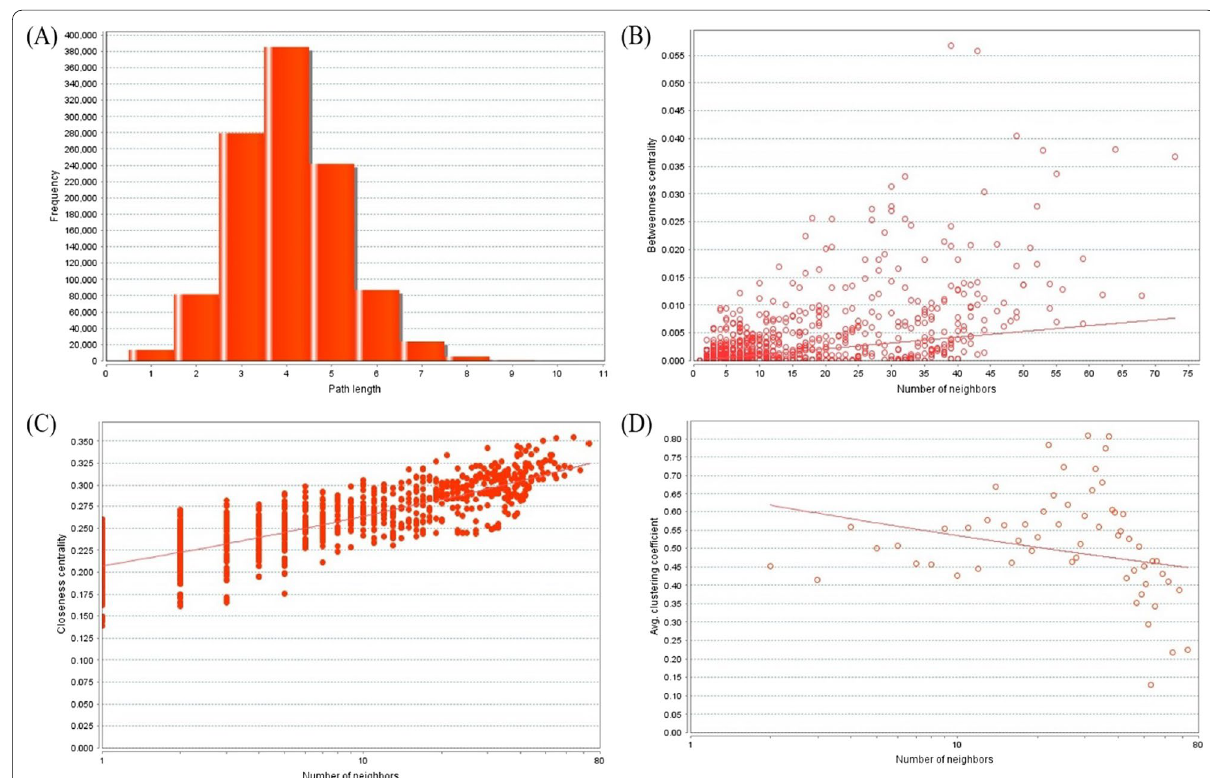
Fig. 4 Topological analysis of a gene interaction network for DEGs with 1058 nodes and 6672 edges. A The histogram represents the shortest path length distribution, demonstrating the network’s small-world feature; B BC distribution fitted by a power law; C represents the clustering coefficient